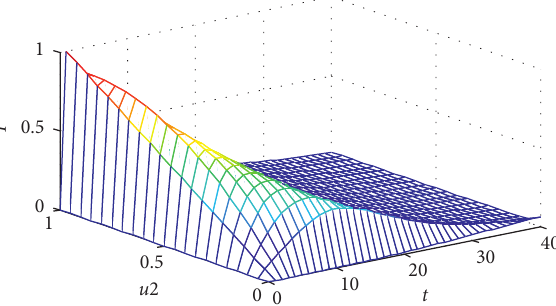
Figure 12: The interaction relation of infection density I and the coefficient of risk infection μ 2 and t (This is helpful to analyze the relationship among ( I ) μ 2 and t ).